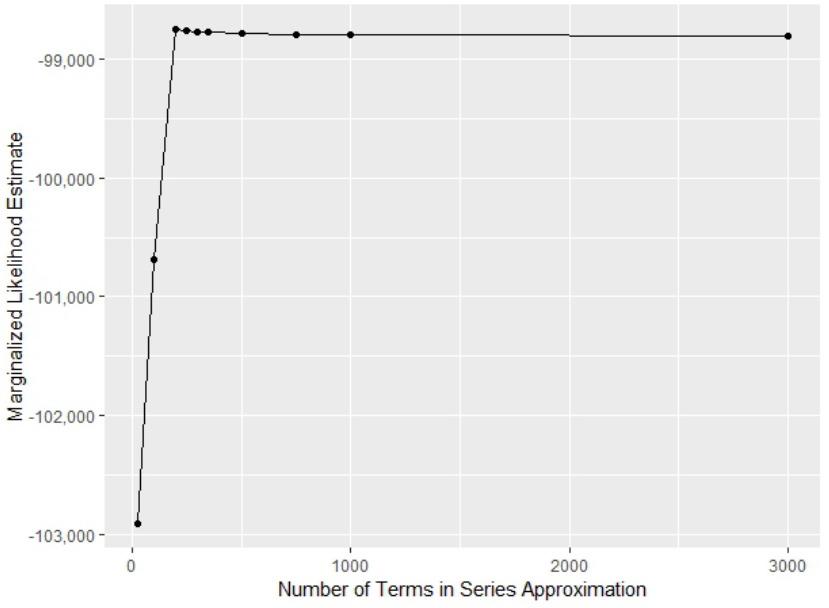
Figure 1. Marginalized Likelihood Estimate Based on Various Truncation Levels of Series Approxi- mation for Marginalized Likelihood in Equation